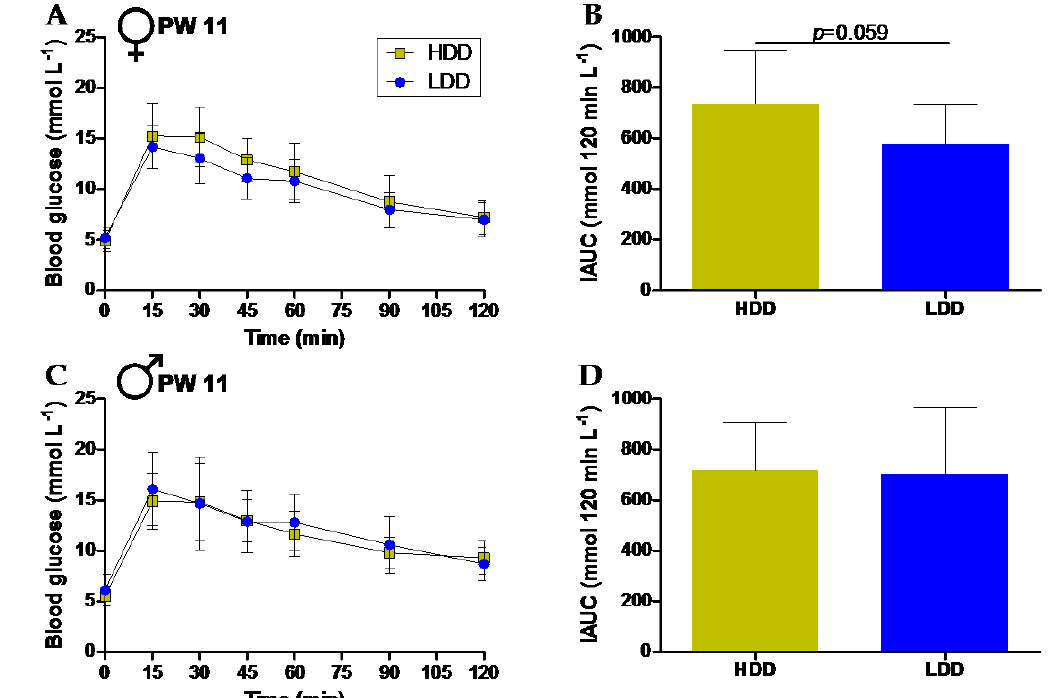
Figure 3. Glucose tolerance after five weeks of HFD feeding (PW 11). Plasma glucose concentrations measured directly before (0 min) and after oral administration of a glucose bolus (2 g kg − 1 BW) in female ( A , n = 12 for HDD and n = 11 for LDD) and male ( C , n = 11 for HDD and n = 12 for LDD) mice. Incremental area under the curve (iAUC) for blood glucose over the 120min period for females ( B ) and males ( D ). Data shown as mean ± s.d.